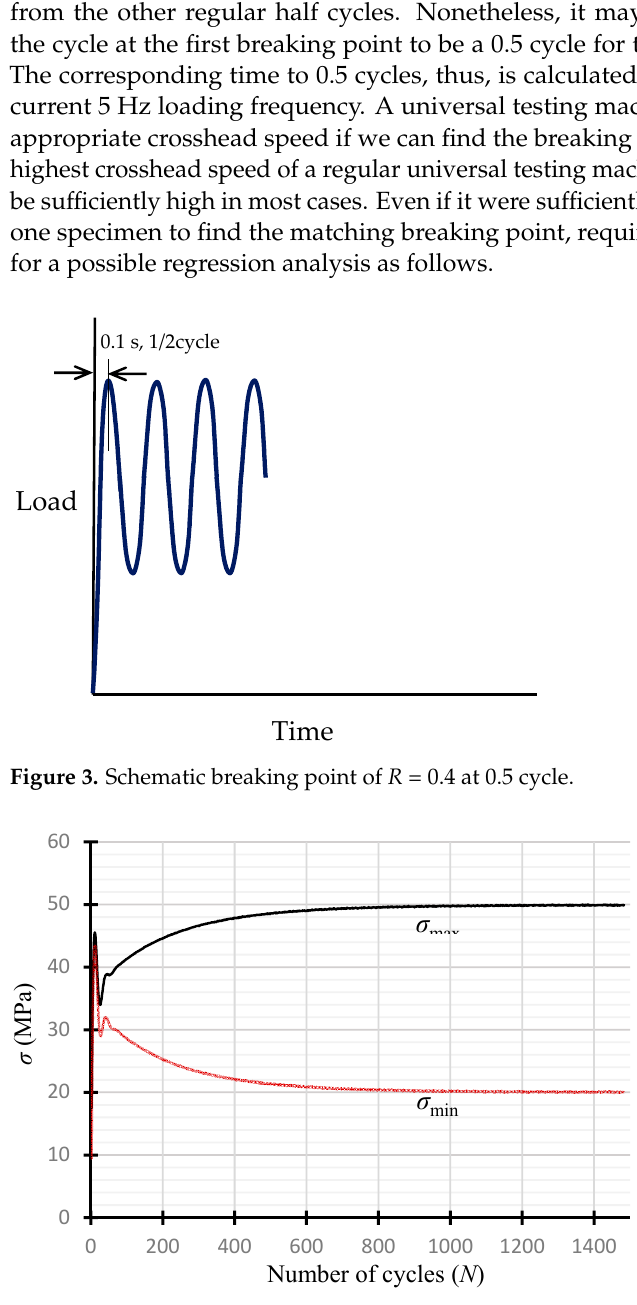
Figure 4. Partial results following the initial fatigue loading set-up for σ max = 50 MPa and σ min = 20 MPa.